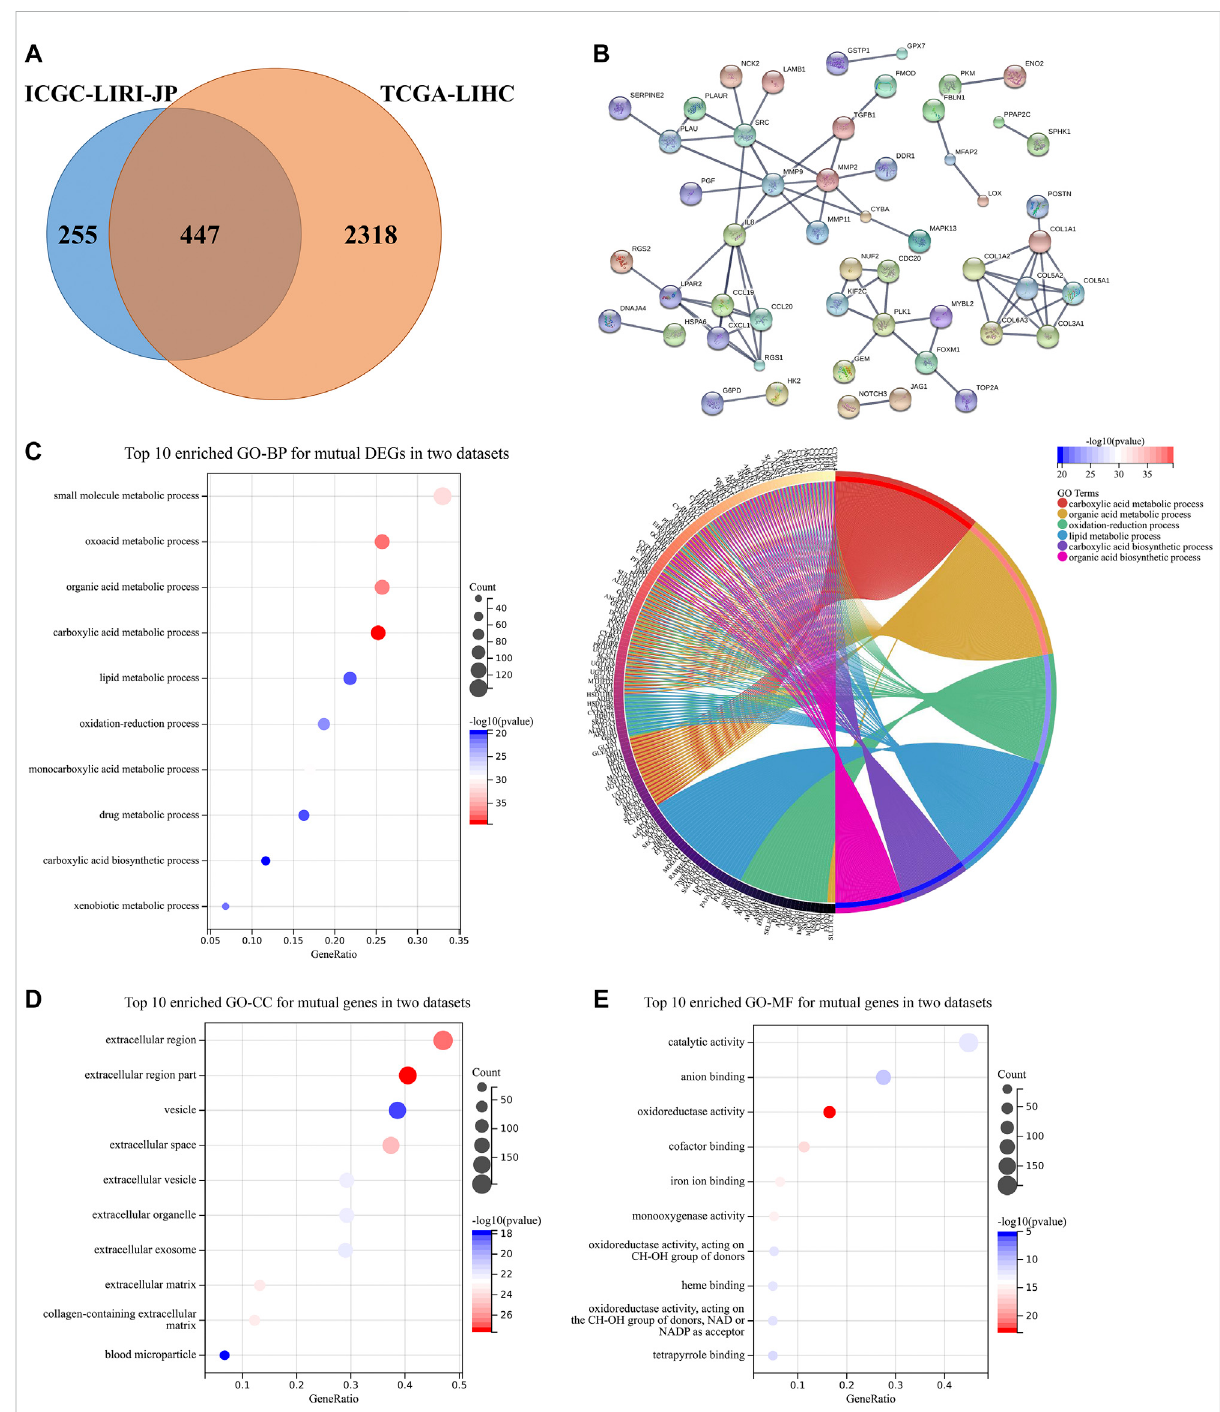
FIGURE 5 DEGs validation and potential pathway enrichments both in the TCGA-LIHC dataset and the ICGC-LIRI-JP dataset. (A) Venn diagram was constructed toshowDEGsbothintheTCGA-LIHCdatasetandtheICGC-LIRI-JPdataset. (B) PPIconstructionofDEGsbothintwodatasets. (C) Top 10 enriched GO-BP and circle plots for mutual DEGs. (D,E) Top 10 enriched GO-CC and GO-MF for mutual DEGs. DEGs, differentially expressed genes; GO, gene ontology; BP, biological process; CC, cellular component; MF, molecular function; PPI, protein-protein